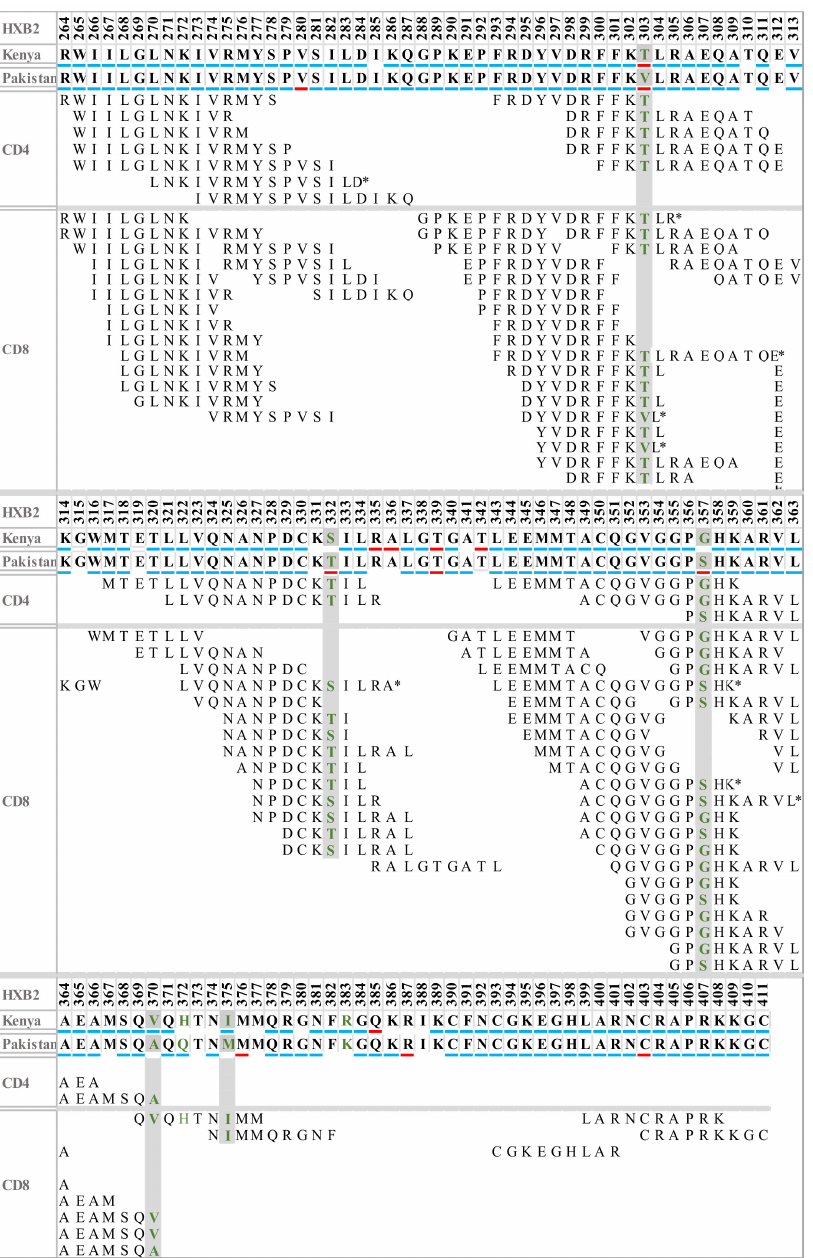
Figure 4. CD4 and CD8 T-cell epitope map on HIV-1 sub-subtype A1 Gag. The amino acids under negative and positive selection pressure are underlined with blue and red colors, respectively. Neutral sites are not underlined. Amino acids dissimilar between the Pakistani and Kenyan sequences are represented with the green color font. The grey color line separates the CD4 and CD8 T-cell epitopes and the steric represents the epitope